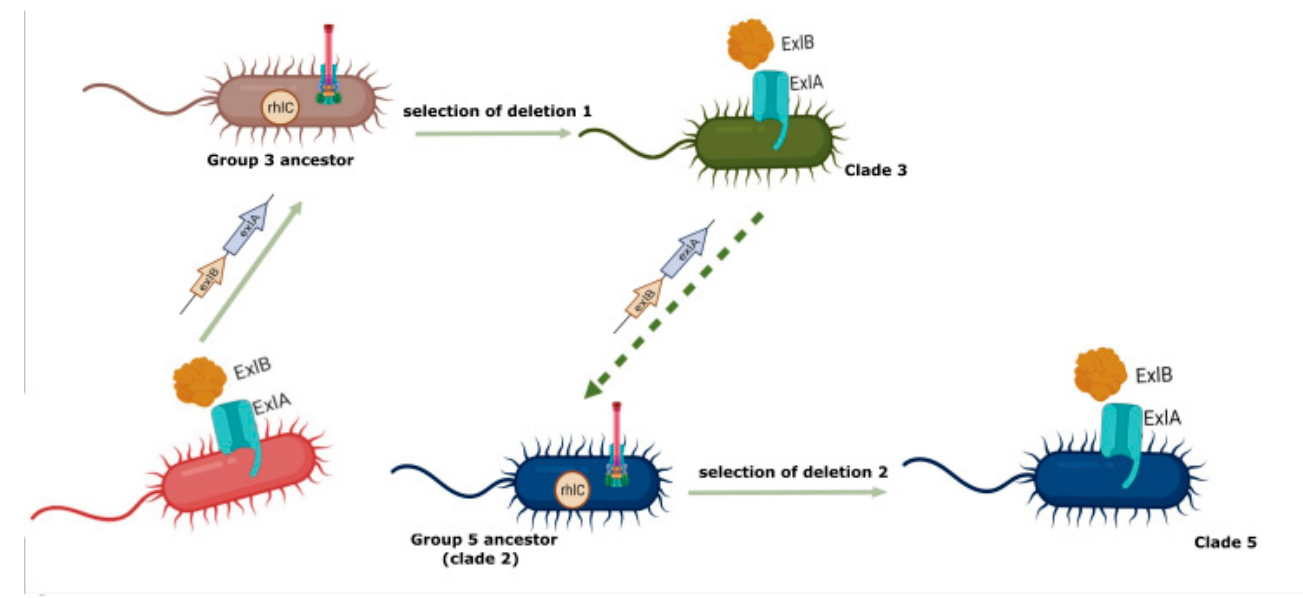
Figure 4. Schematic representation of the proposed hypothesis for the origin of strains belonging to clades 3 and 5. We propose that the exlBA operon was transferred by HGT from a non-related bacteria to the P. aeruginosa ancestor of clade 3, and that the inheritance of these genes encoding for the production of exolysin A was incompatible with the production of the T3SS, so the deletion of the five operons encoding this virulence factor was selected; concomitantly in order to compensate for the lack of T3SS the deletion of rhlC and of phz were selected. In turn, phylogroup 5 was originated by the HGT from a P. aeruginosa clade 3 strain of the exlBA operon to a P. aeruginosa strain possibly belonging to clade 2, and the deletion of genes encoding for the T3SS, rhlC, and phzH were selected in independent events. This image was created by biorender.com